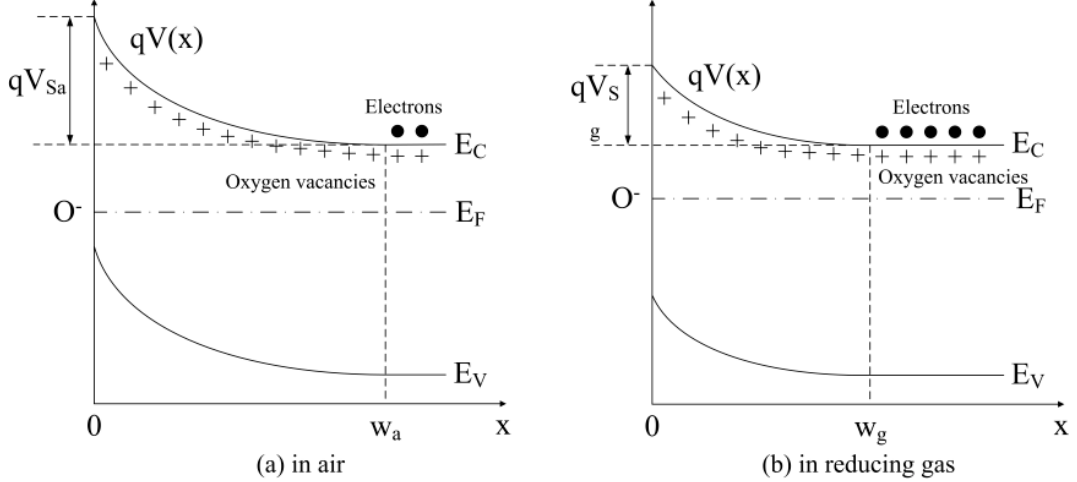
Figure 4. Potential barrier in the depletion layer of a semiconductor grain ( a ) in air and ( b ) in reducing gas.